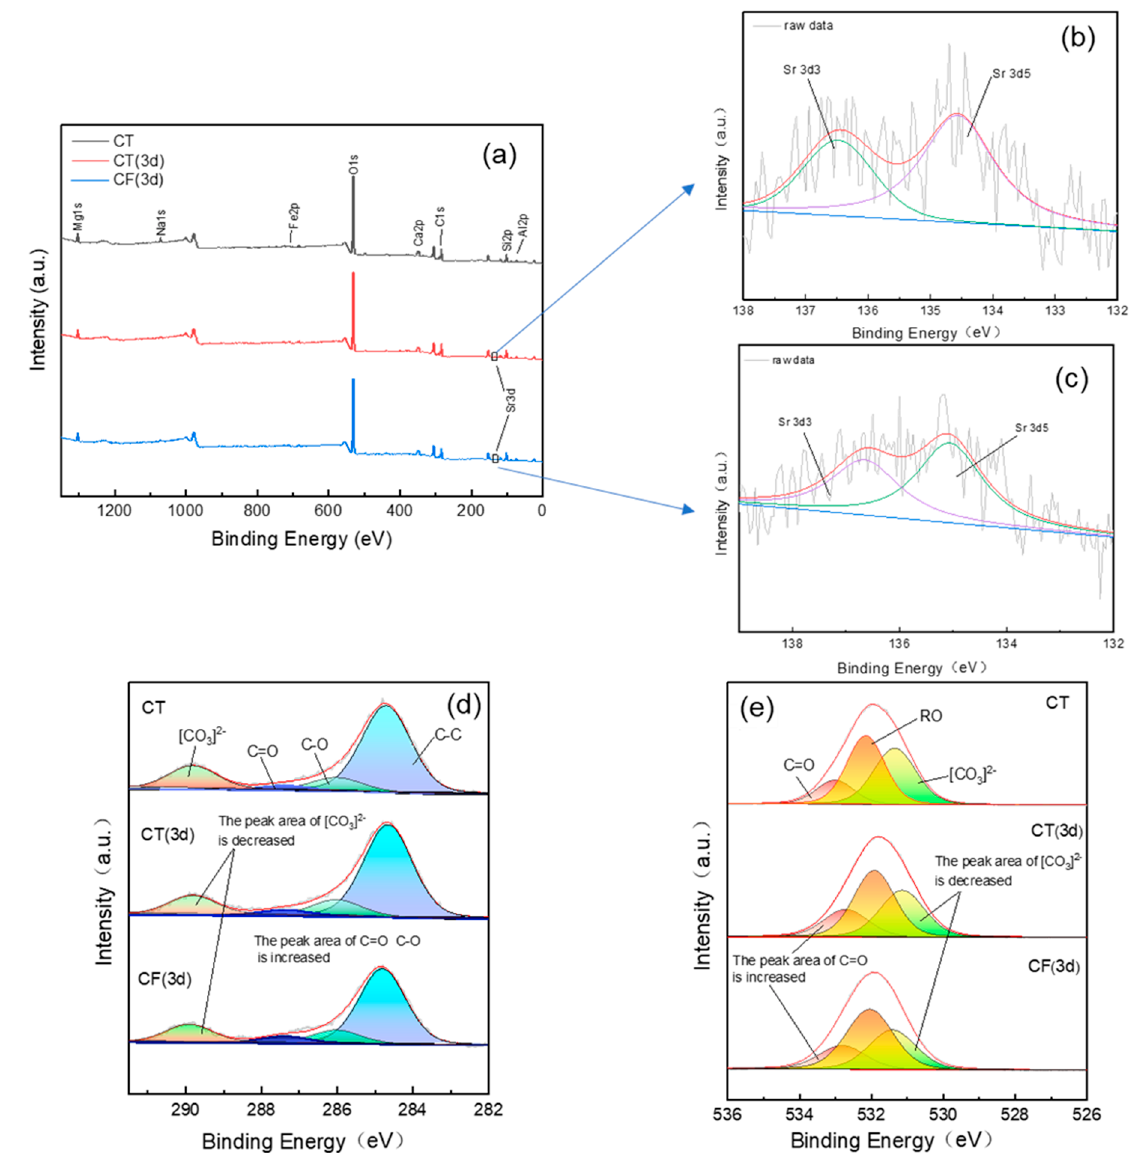
Figure 7. XPS spectra of claystone before and after sorption with CT and CF: ( a ) total survey scans; ( b ) Sr 3d spectra (CT 3d); ( c ) Sr 3d spectra (CF 3d); ( d ) C 1s spectra; ( e ) O 1s spectra. Without the action of colloids, Sr appears in the full spectrum after 3 days of sorption,